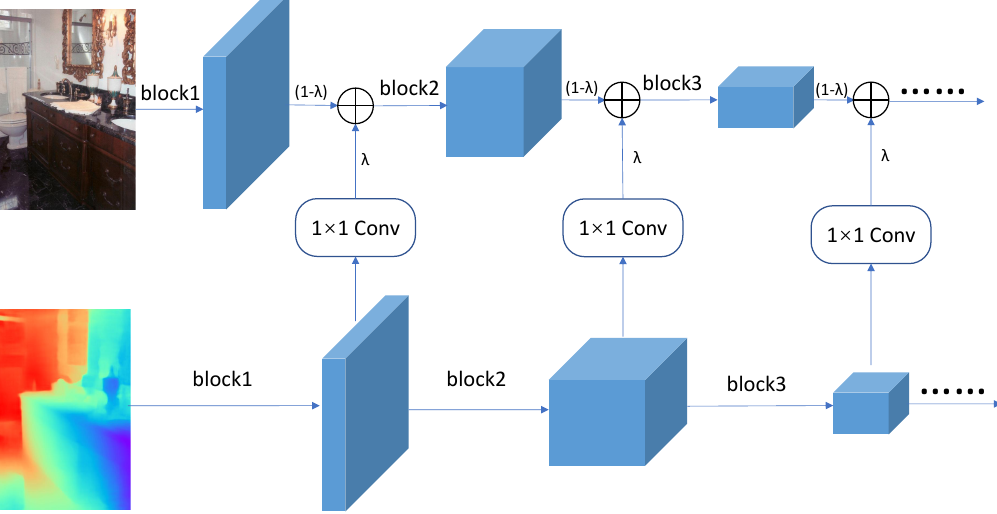
Figure 3. After each block of RGB encoder and depth encoder, the depth feature is fed into 1 × 1 convolution, and then we add the RGB and depth features together via a proportion parameter λ